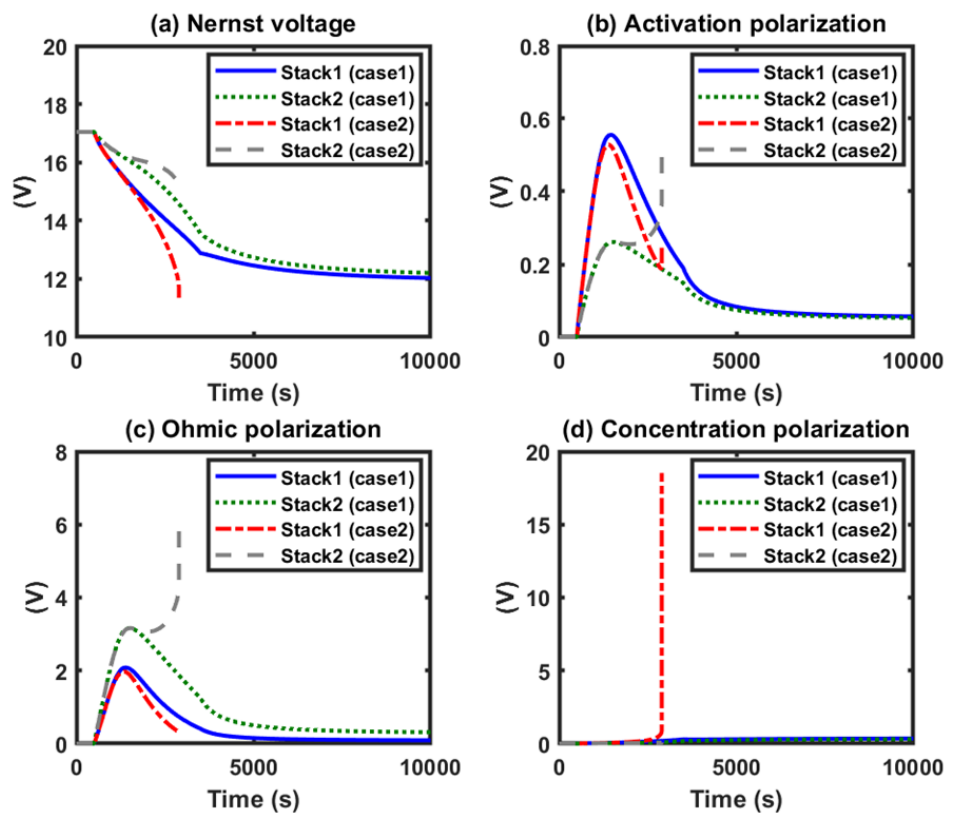
Figure 8. Transient response of the stack voltages when the two employed FC stacks have different ohmic properties. Case 1 includes the heat exchange between stacks, whereas case 2 excludes it. ( a ) Nernst voltage, ( b ) activation polarization, ( c ) ohmic polarization, and ( d ) concentration polarization. Stack voltage differs largely when there is no heat exchange between stacks.